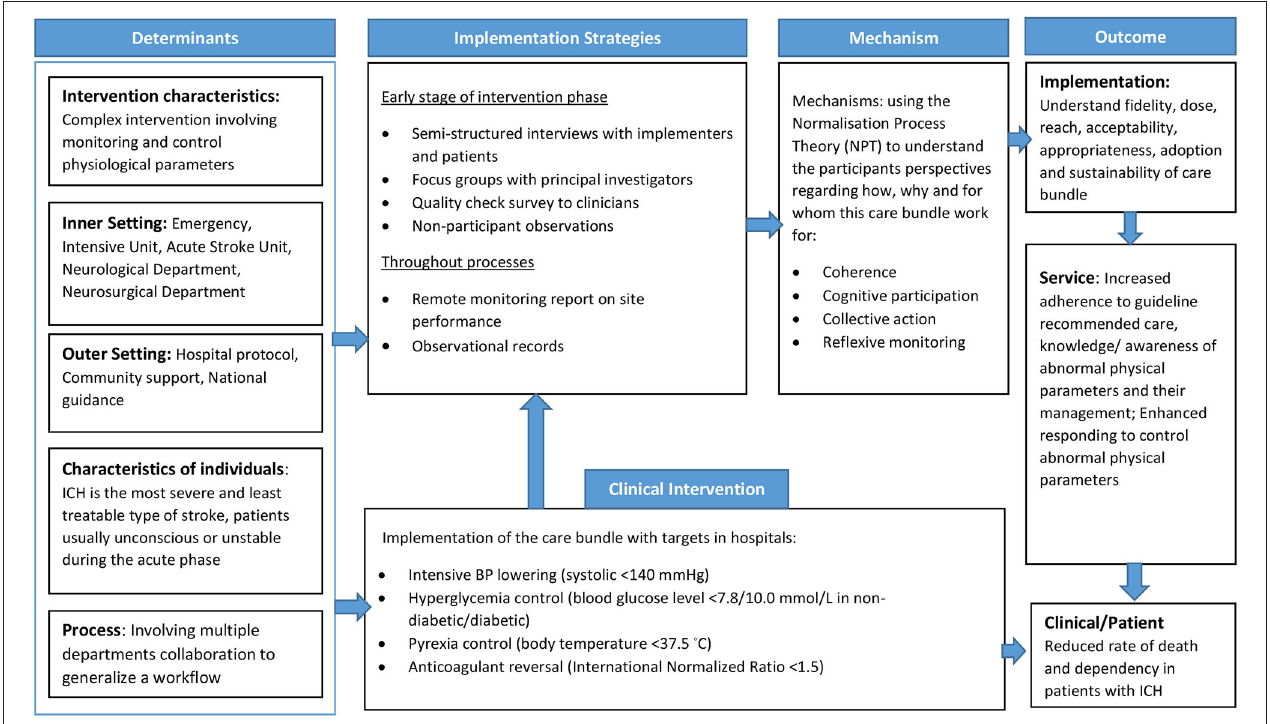
FIGURE 2 | Implementation research logic model of INTERACT3 process